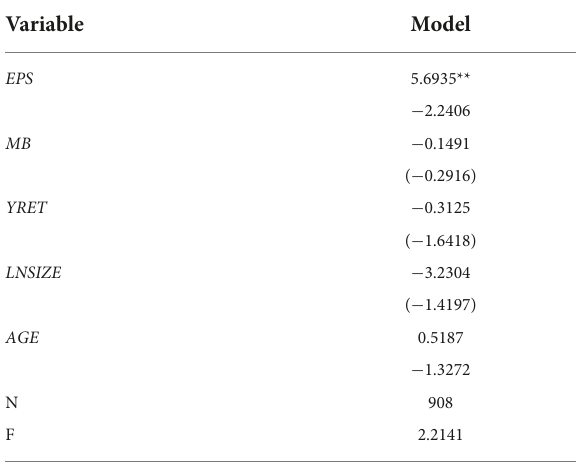
TABLE 8 Relationship between earnings per share and company